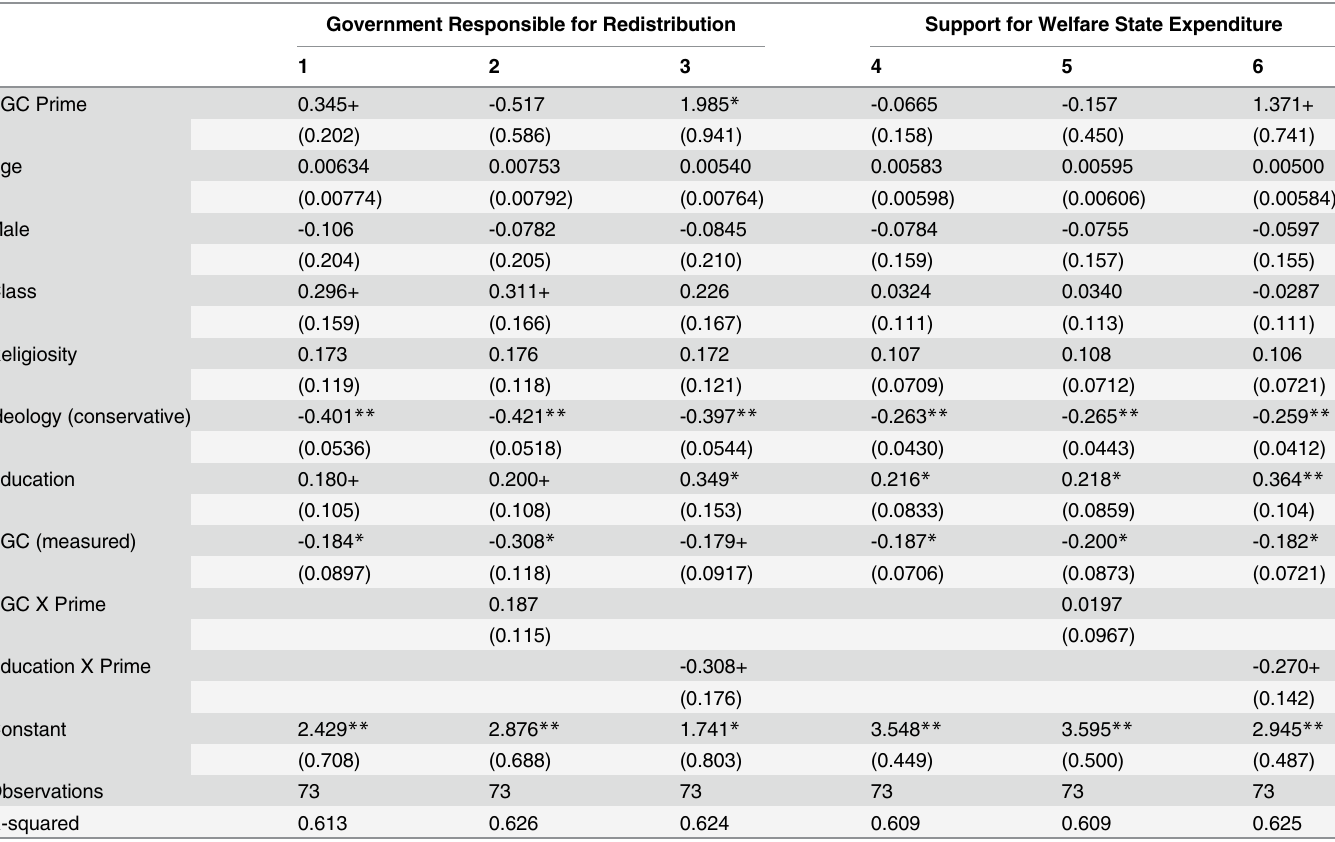
Table 4. Effect of BGC on WSA among American Jews (Study